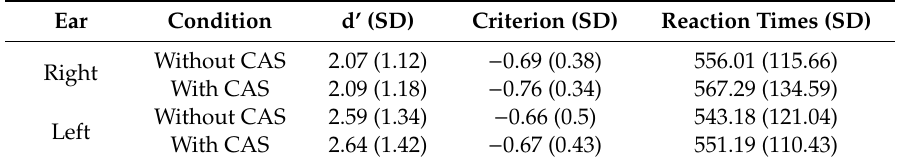
Table 7. Descriptive statistics of d’ (sensitivity), criterion and reaction times obtained in the active-discrimination condition (P300 task) without and with contralateral acoustic stimulation (CAS) in the two ears. SD = Standard Deviation.